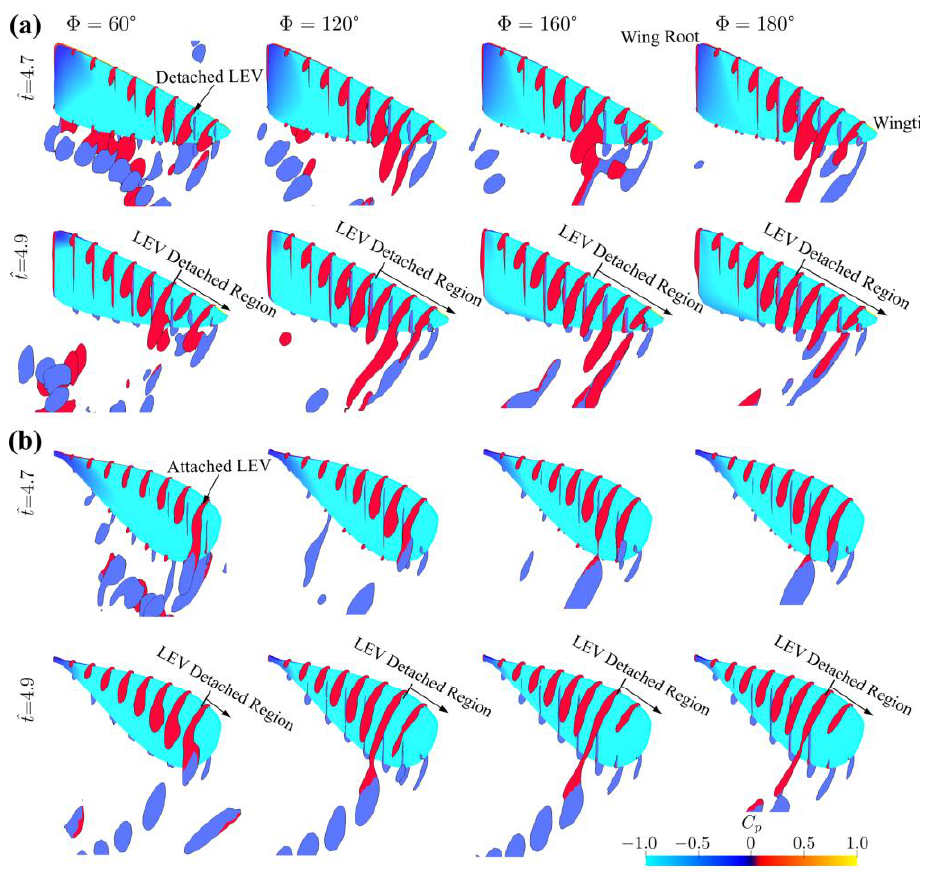
Figure 15. Flow structures for different stroke amplitudes for ( a ) 𝑟̂ 1 = 0.4, ( b ) 𝑟̂ 1 = 0.6.